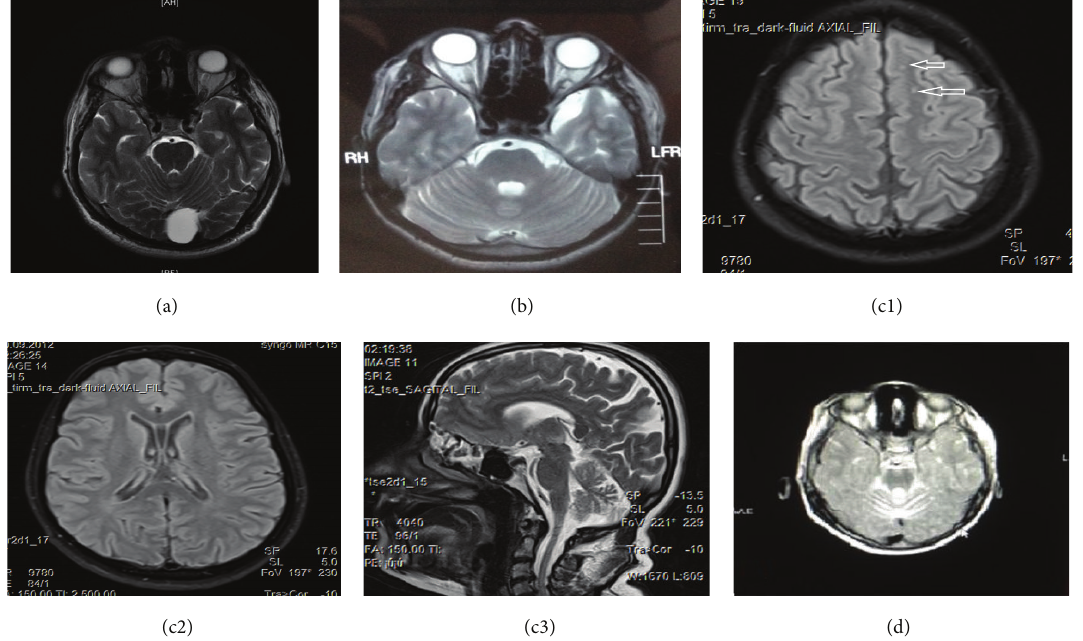
Figure 2: Arachnoid cyst in posterior vermian area in Patient II.5 (a); left temporal arachnoid cyst in Patient II.1 (b); multiple nodular (white arrows) lesions (c1), cavum septum pellucidum-cavum vergae variation (c2), and cerebellar atrophy in Patient II.11 (c3); cerebellar atrophy in Patient III.5